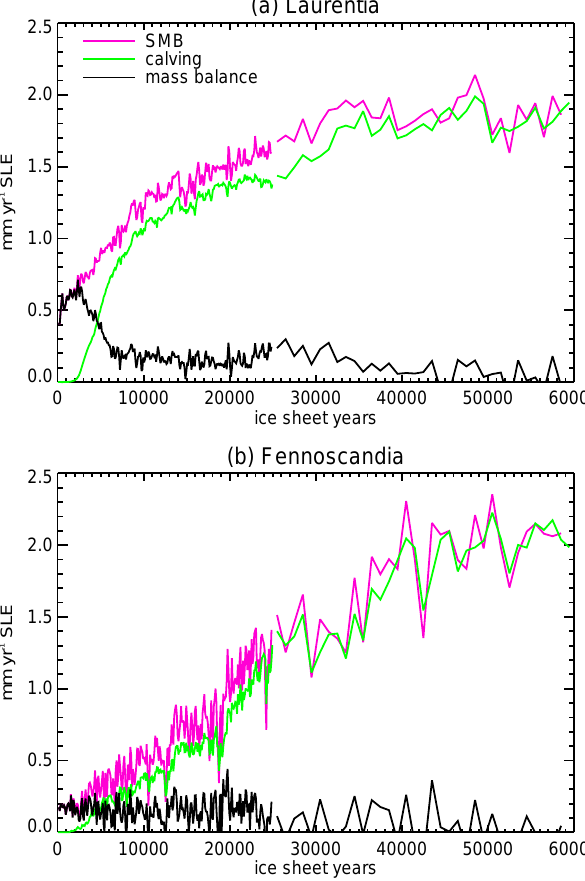
Fig. 13. Components of ice-sheet mass balance in the incipient glacial experiments shown as timeseries of area-integrals over the final ice-sheet area in each domain. The first 25ka of the time- series are 100-yr means from the 1 : 10 experiment, the remainder are 1000-yr means from the 1 : 100